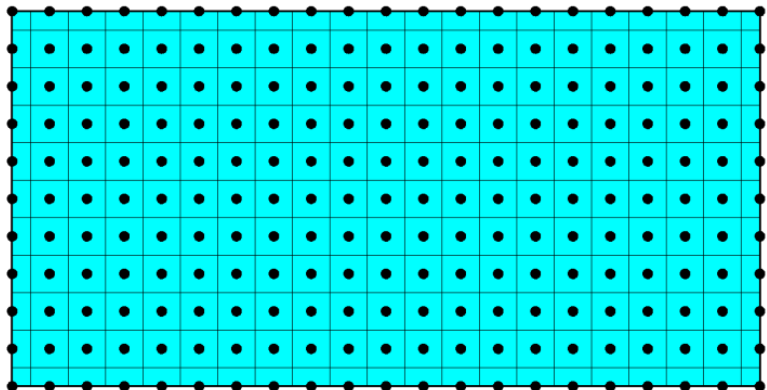
Figure 2. The spatial discretization of the rectangular plate. In Figure 2, the black dots represent the collocation points (nodes). Due to the symme- try of the structure and load, the constrains to rigid-body displacement need be imposed at the two symmetrical axes of the plate. It is necessary to collocate nodes on the boundary. The volume of subdomain associated with the boundary node is ∆ 2 h /2 or ∆ 2 h /4. When the horizon size is specified as δ = 3.015 ∆ , three different grid sizes ∆ = L /50, L /100, and L /200 are used to show the influence of the grid density on the convergence and computational accuracy, as illustrated in Figures 3 and